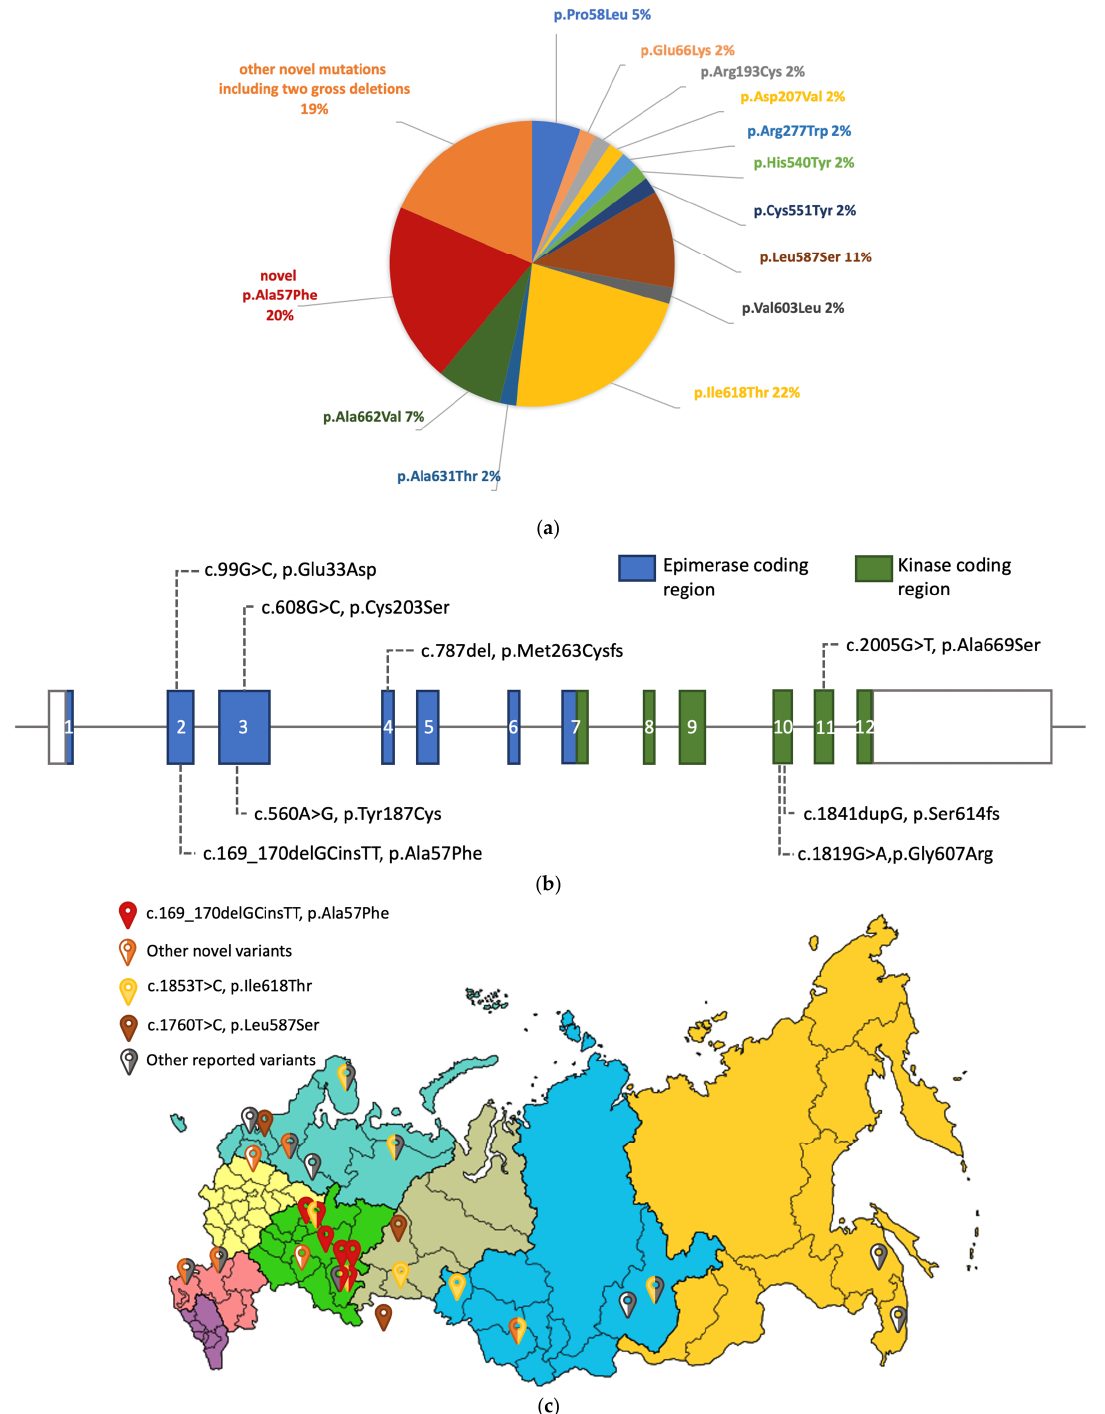
Figure 1. MutationalspectrumofGNEMinRussia. ( a )Distributionofalldetectedvariants; ( b )Distribution of novel causative variants on the scheme of the GNE gene, and ( c ) Place of birth of 26 out of 27 unrelated patients with variants in the GNE gene are presented on the map of the Russian Federation. One patient was from Kazakhstan, but she identified her ancestry as Russian. Three variants were detected in a homozygous state (those families are identified as full-colored signs). Other variants were revealed only in a compound heterozygous state (those families are identified as half-colored signs). Only one variant, p.Ala57Phe, is clustered in neighboring regions of